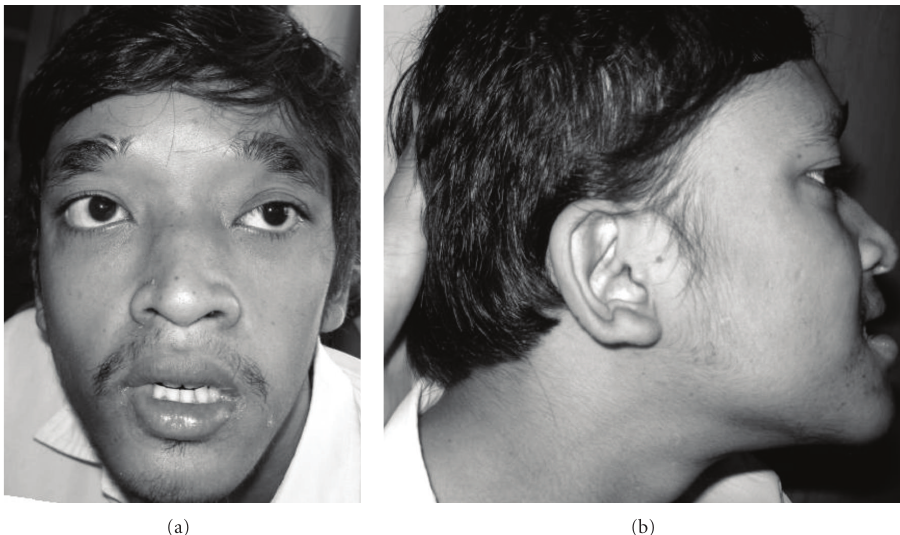
Figure 1: Photograph of Indonesian patient with Mowat-Wilson syndrome. Our patient in his 19 years of age showed striking facial gestalts of MWS such as large eyebrows with medial flaring (a) and uplifted ear lobules (b). Other dysmorphisms such as long face, deep-set eyes, upward slanting palpebral fissures, hypertelorism, strabismus, saddle nose with prominent rounded nasal tip, prominent columella, low-set and posteriorly rotated ears, prominent and triangular pointed chin, small mouth, full lips, and prognathia are noted.